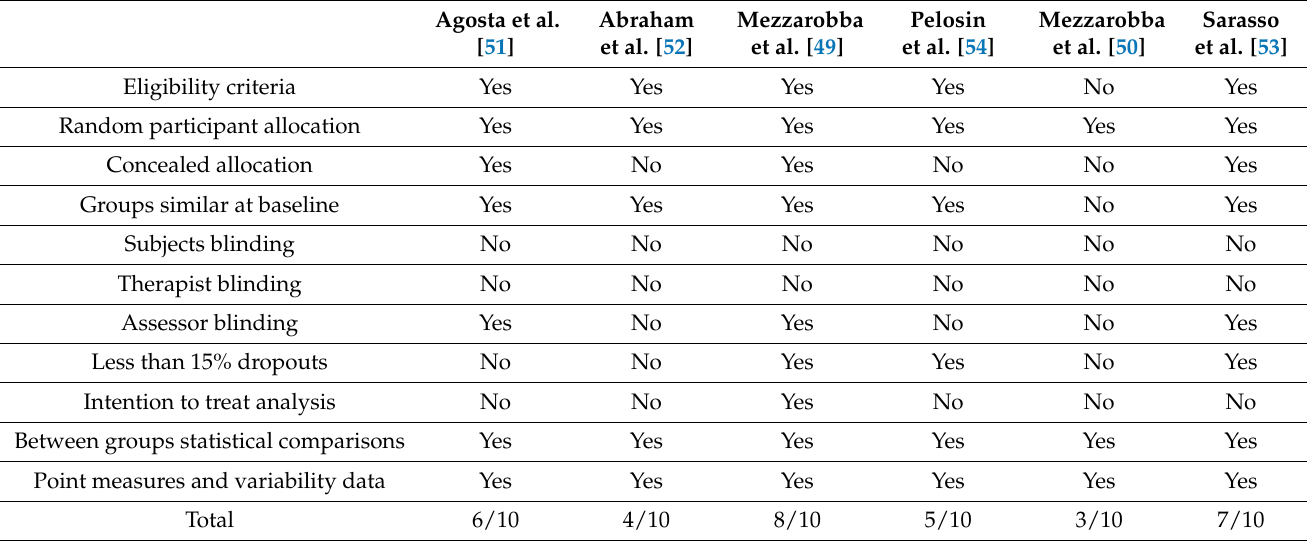
Table 3. Risk of bias: PEDro Scale. Agosta et